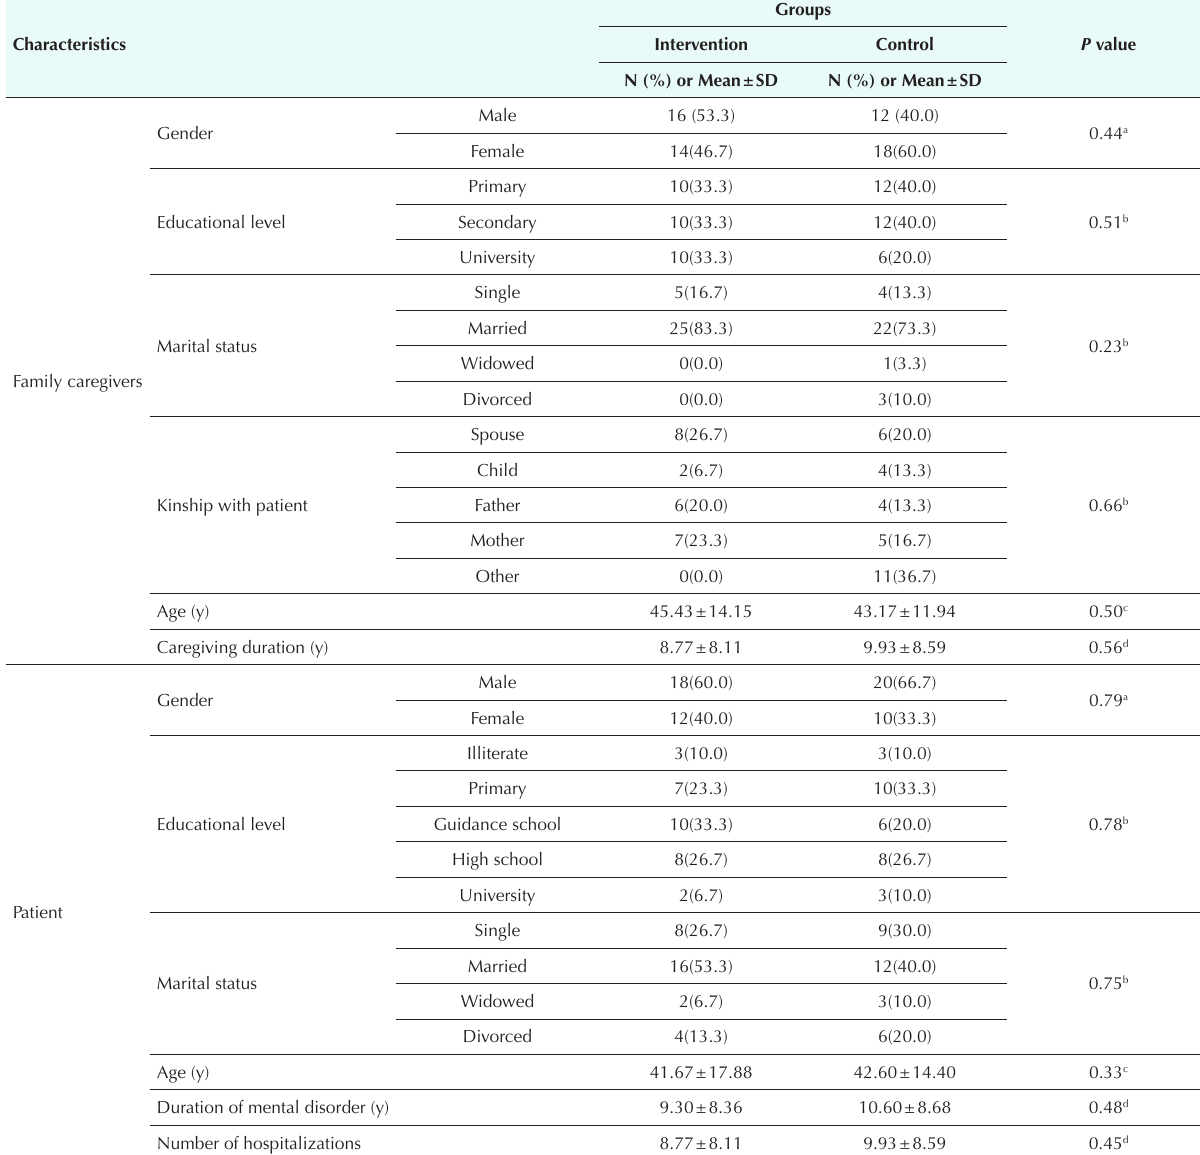
Table 2. Between-group comparisons in terms of participants’ and their patients’ characteristics